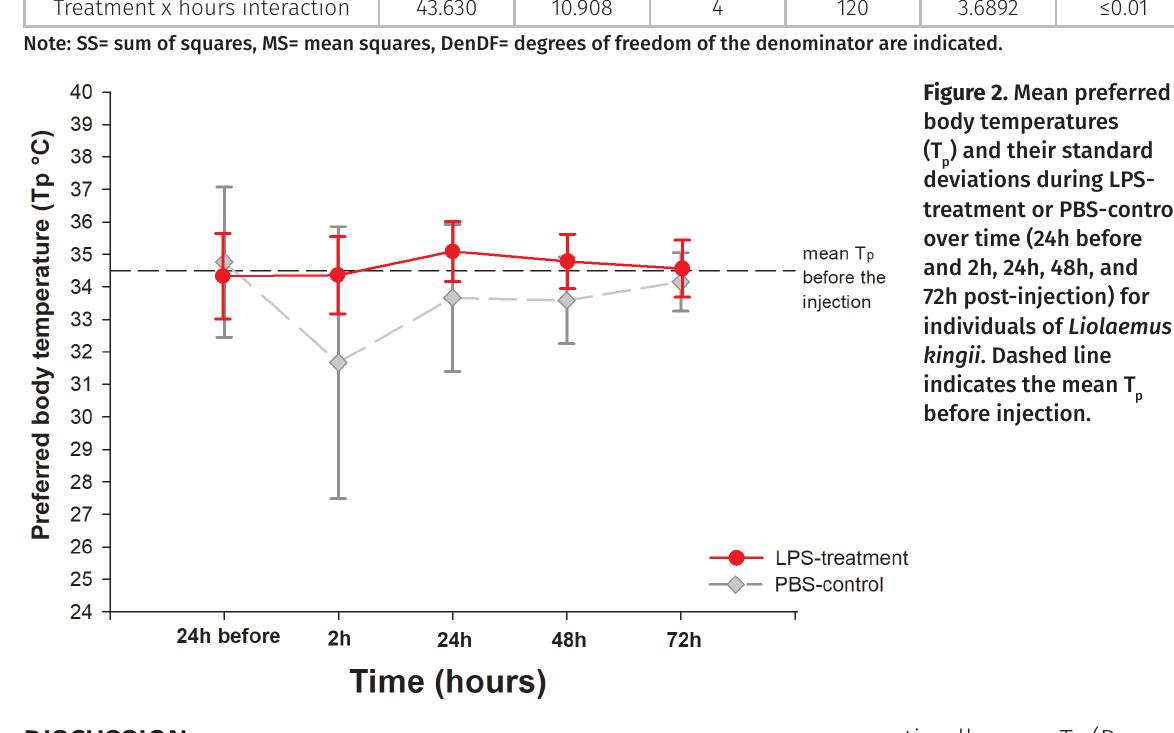
Table III. Significance of the fixed effects of the best generalized mixed model of the preferred body temperature (T ) over time (24h before and 2h, 24h, 48h, and 72h post-injection) between treatments (LPS and PBS) for p individuals of Liolaemus kingii . SS MS Num DenDF F value Pr(>F) 48.796 12.199 4.1260 ≤0.005